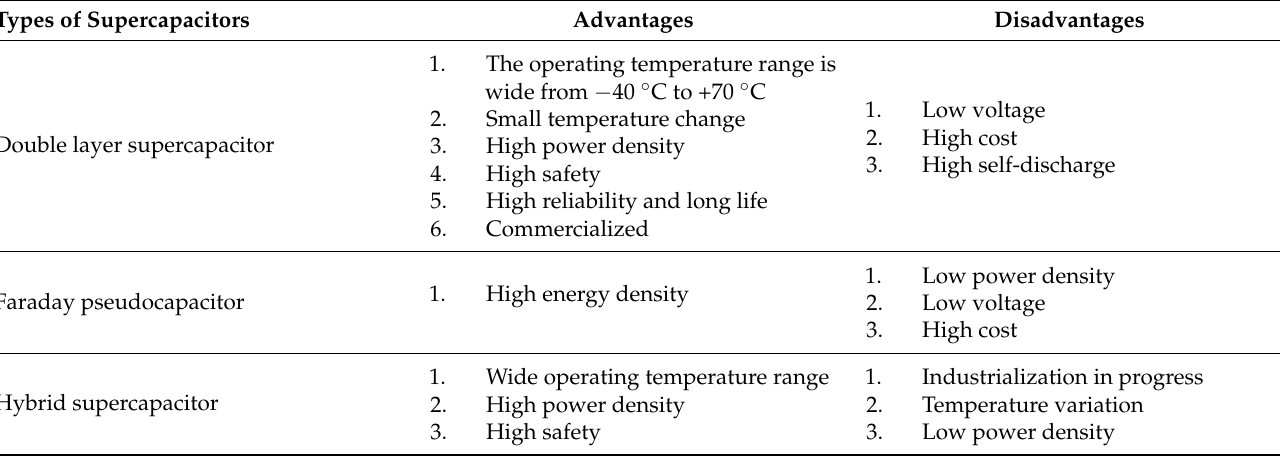
Table 2. Advantages and disadvantages of the three kinds of